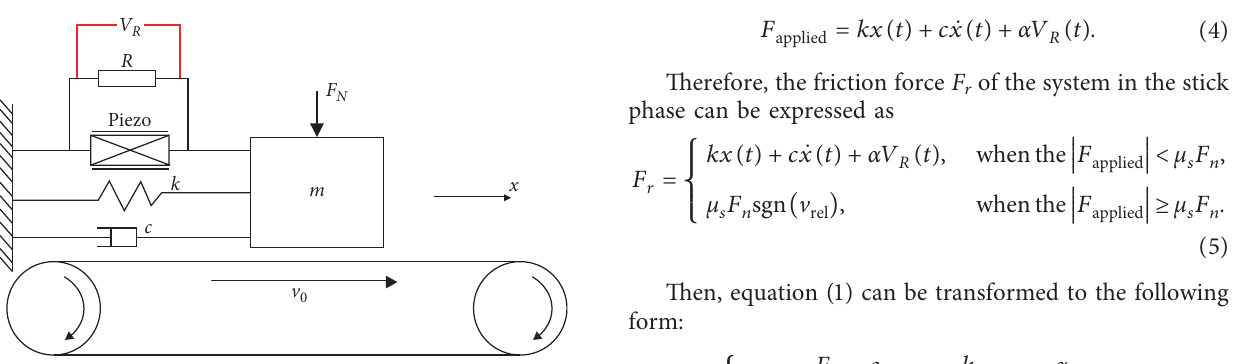
Figure 1: One-degree-of-freedom friction system with piezo- electric